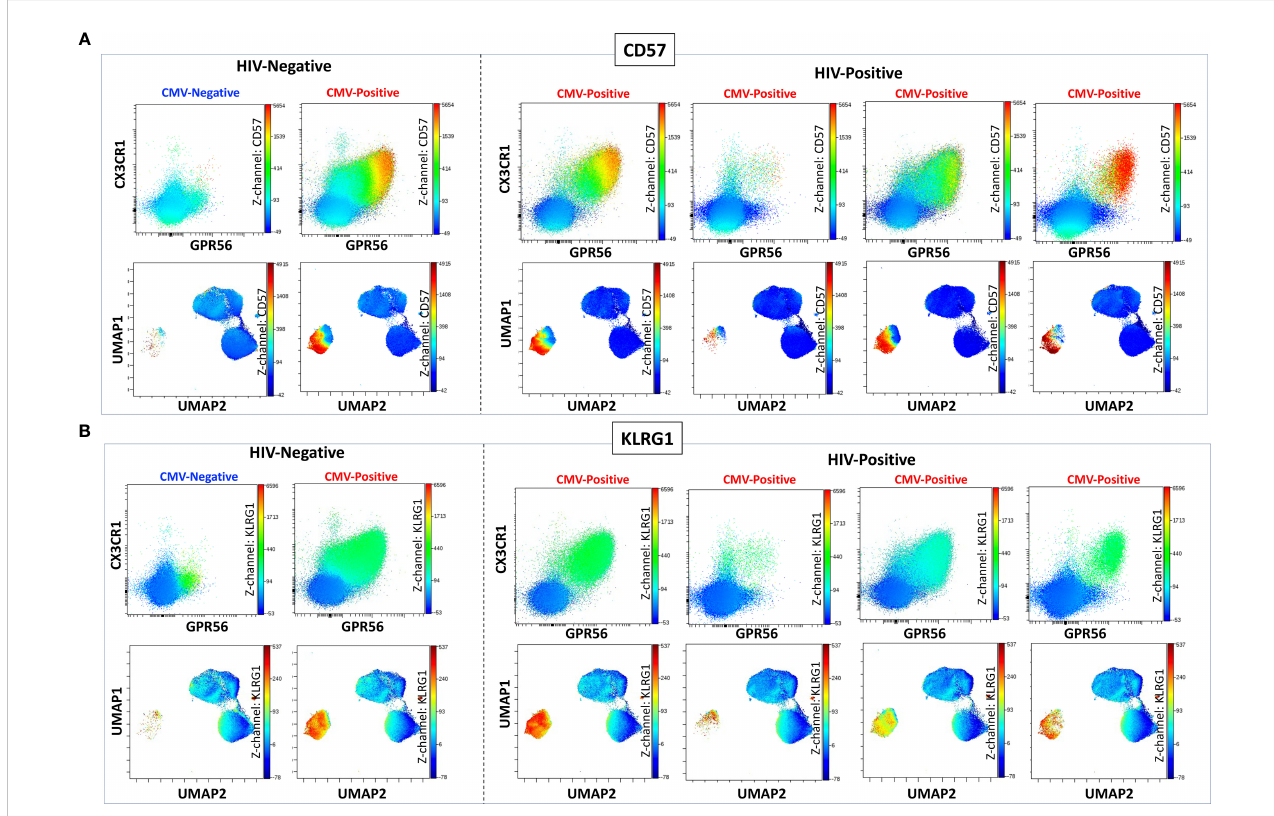
FIGURE 3 CGC + CD4 + T cells express CX3CR1 and GPR56 with variable expression of CD57. The two-dimensional fl ow cytometry panel shows the co-expression of CX3CR1 and GPR56 and highlights CD57 expression on these cells compared to non-CGC + T cells. UMAP shows CGC + CD4 + cluster and variable expression of CD57 (A) . KLRG1 expression on CGC + CD4 + T cells is demonstrated by two-dimensional plots and UMAP (B) . Participants in this analysis included two HIV-negative persons with and without CMV, and four CMV-positive